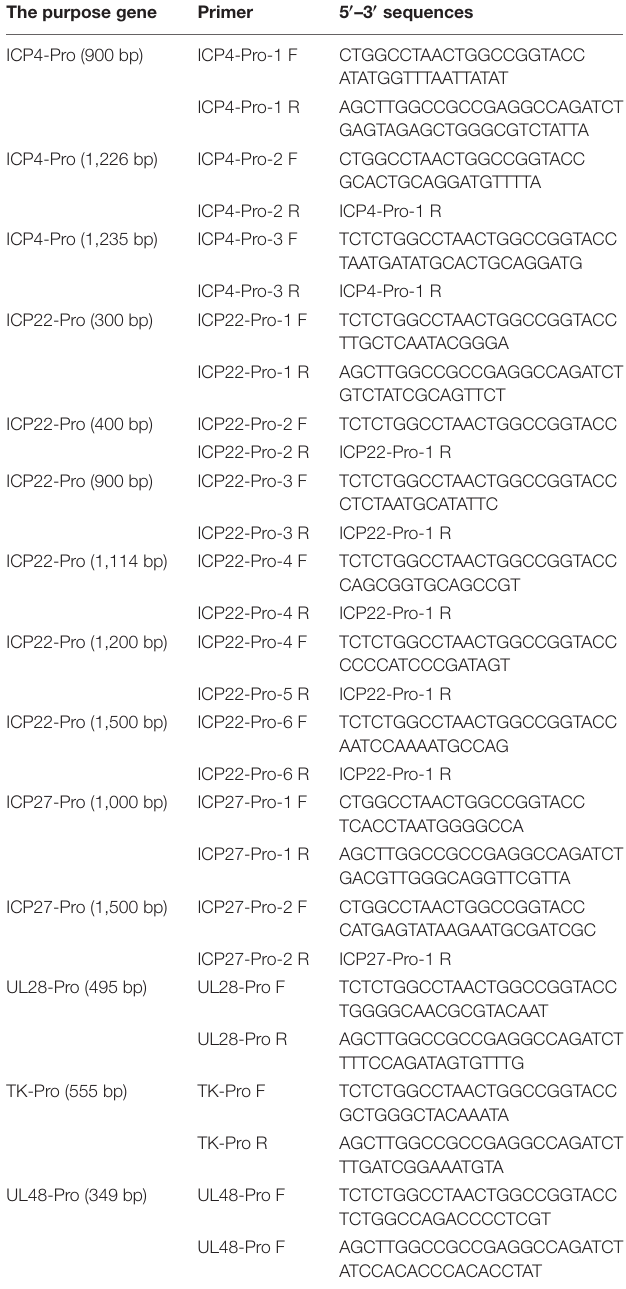
TABLE 1 | Design of luciferase reporter plasmids for different gene